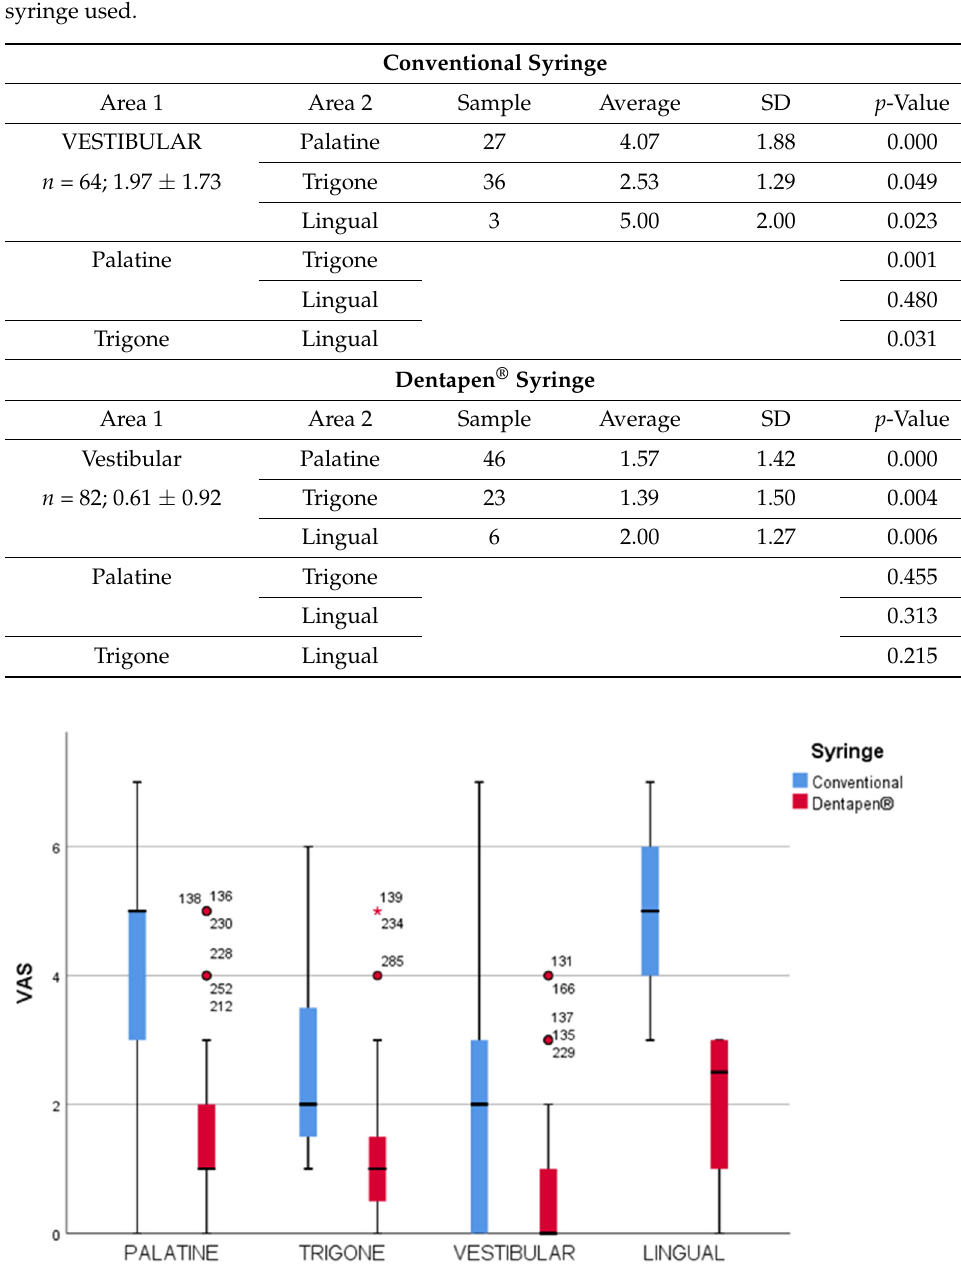
Table 4. VAS comparison and statistical significance based on the area of injection and the type of syringe used.